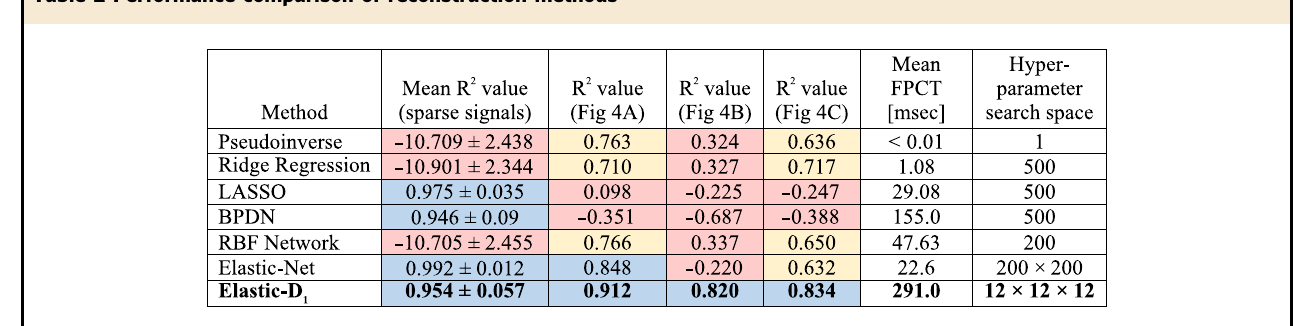
Table 2 Performance comparison of reconstruction methods